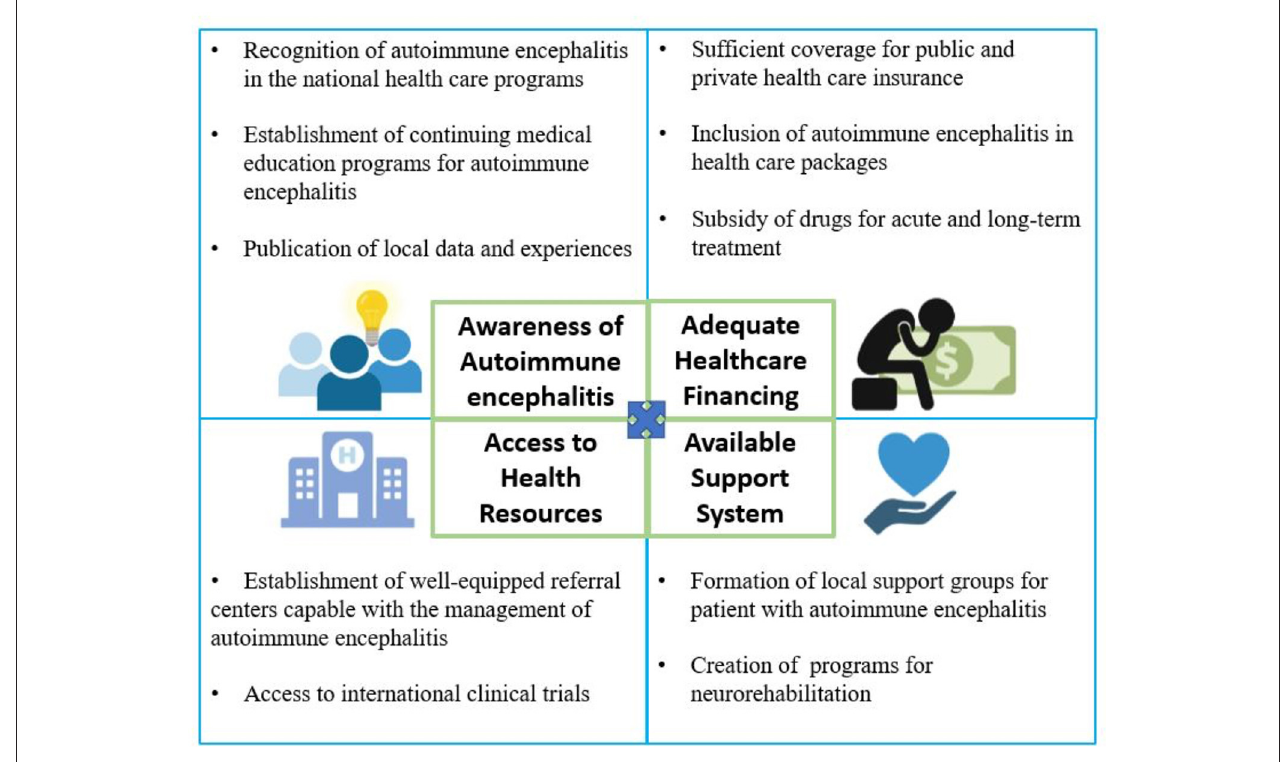
FIGURE 2 | Conceptual framework of the gaps in the management of autoimmune encephalitis in the